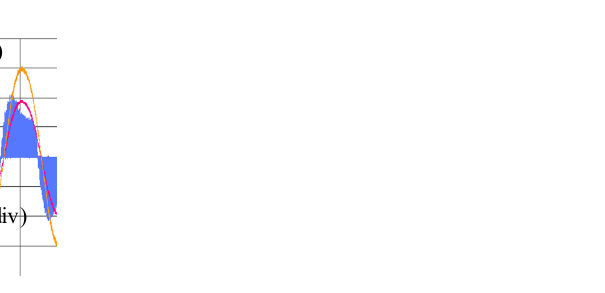
o = 1 kW. Time: 10 ms/div.